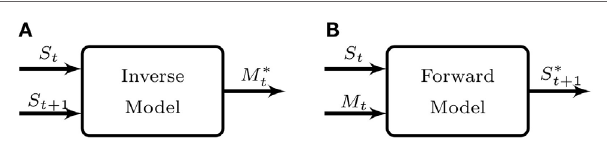
FigUre 1 | internal models canonical representation . (a) Inverse model: given the current sensory state St and a desired sensory state for time t + 1, St + 1 this model suggests the motor command M about the change in the sensory state of the agent. (B) Forward model: given the current sensory state S t and a motor command M t , the forward model predicts the resulting sensory state prediction S executed. It is worth noting the difference between S the actual expected state for the next time-step, but the latter may require several time-steps in order to be